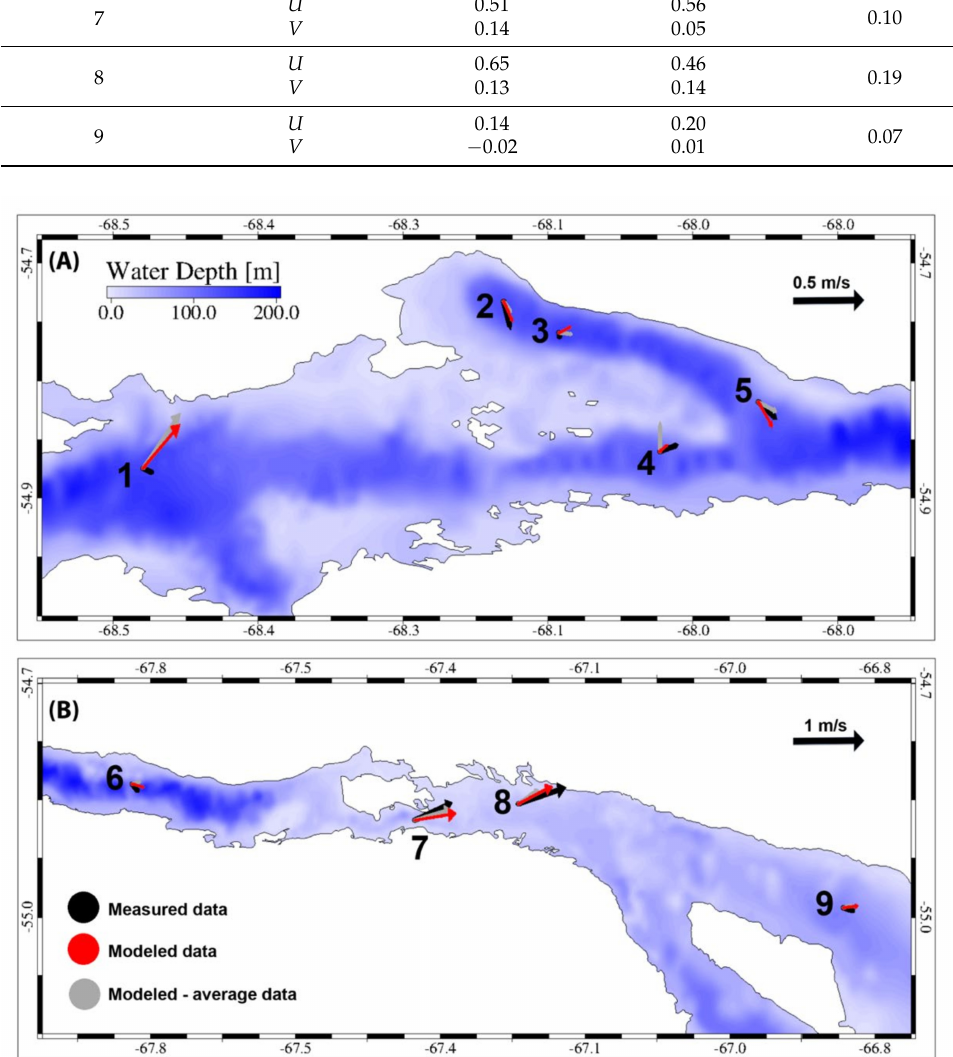
Figure 4. Comparison between model results (red vectors, corresponding to MOD in Table 2) and observed surface currents measured at 9 stations along the BC (black vector, OBS in Table 2). Gray vectors indicate the average modeled values obtained from the whole annual simulation